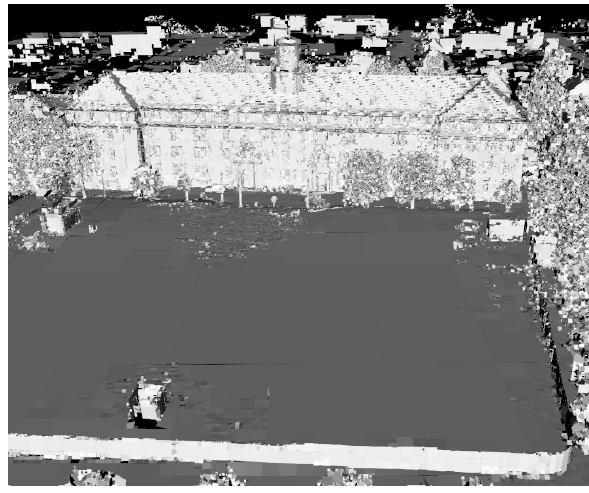
Figure 7. Exemplary result of the model generation approach.